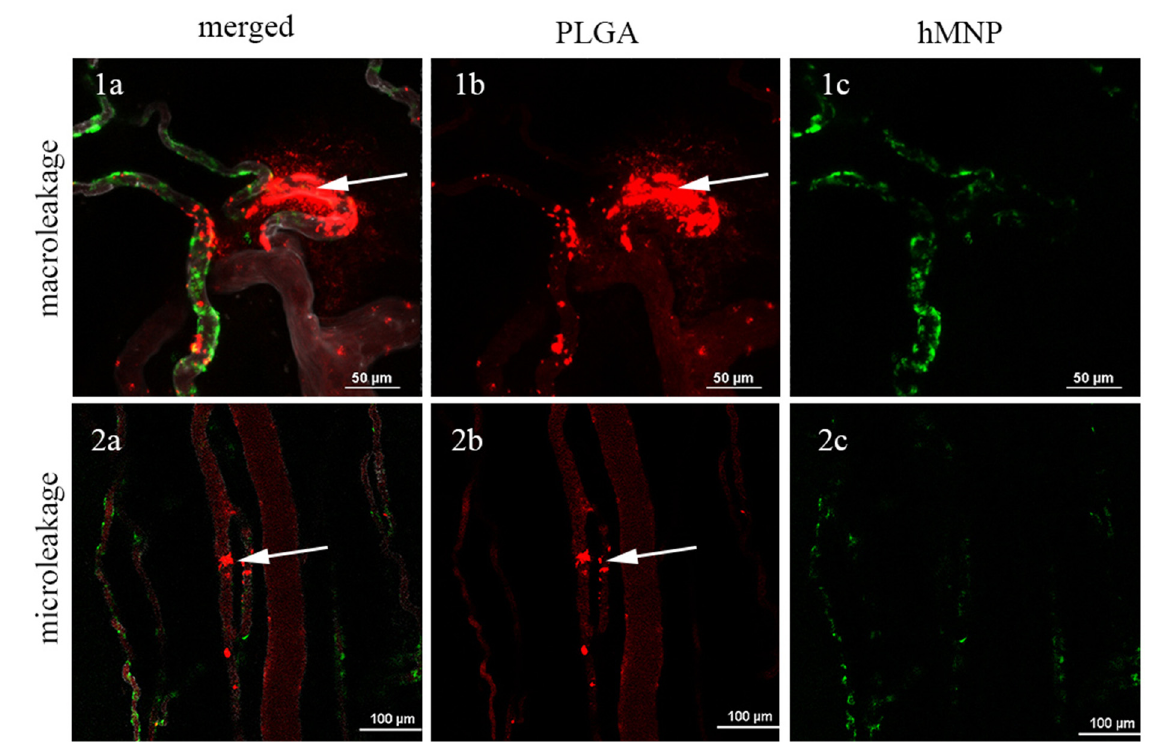
Figure 9. Investigation of nanoparticle extravasation in tumor and peritumoral area in 4T1 tumor-bearing mice. Representative images of macroleakages ( 1 ) and microleakages ( 2 ): ( a ) merged images; ( b ) PLGA-Cy5 NP (red channel); ( c ) hMNP-FITC (green channel). Leakage areas are indicated by white arrows. Scale bar—50 µm ( 1 ) and 100 µm ( 2 ).